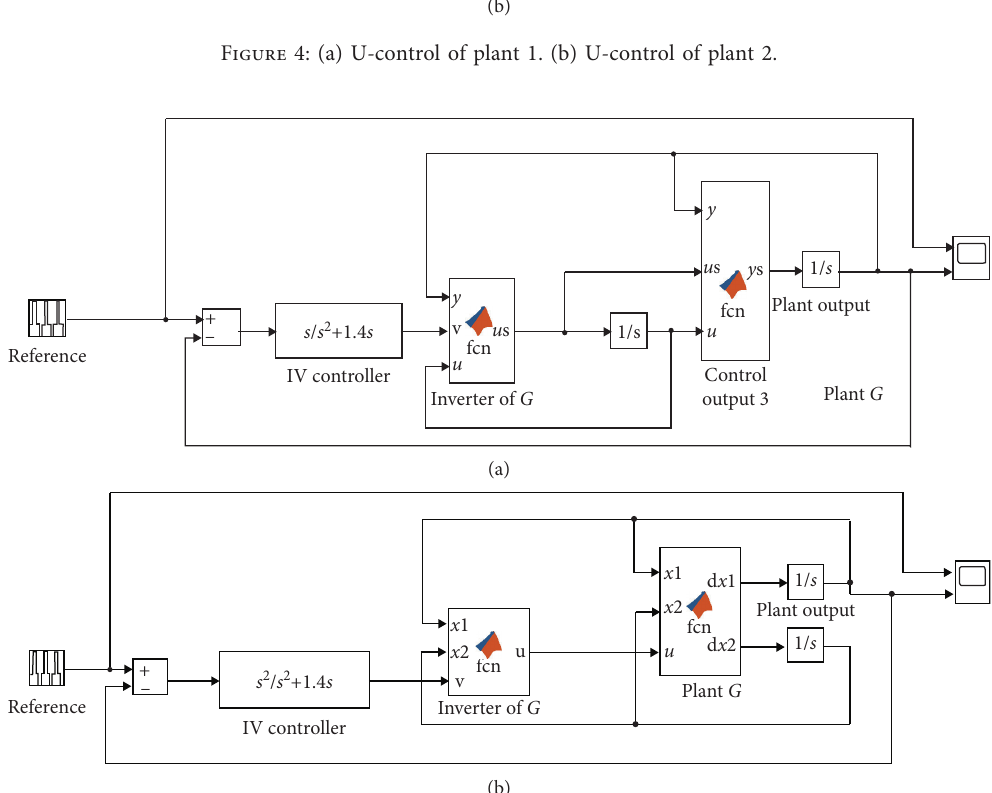
Figure 5: (a) U-control of plant 3. (b) U-control of plant